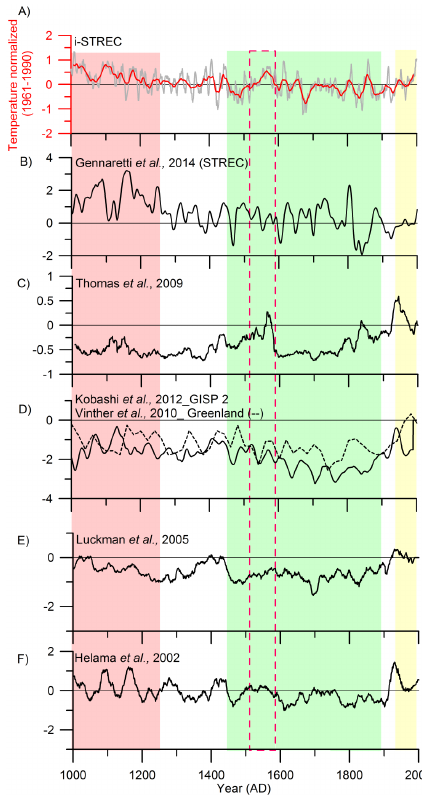
Figure 5. Comparison between i-STREC and other temperature reconstructions (data obtained from NOAA). (a) i-STREC from northeastern Canada. (b) STREC from tree-ring width, in the same region. (c) July–September temperature from varved sediments, Baffin Island, Arctic Canada (Thomas and Brinner, 2008). (d) An- nual surface temperature from GISP 2 ice core, in Greenland. (e) May–August maximum temperature from maximum latewood density and tree-ring width, Canadian Rockies. (f) July temperature from tree-ring width, northern Finland. Shading based on i-STREC is shown to ease comparison with the other reconstructions com- piled: warmer (pink, colder (green) and modern periods (yellow). All reconstructions have been smoothed with a 21-year filter and normalized